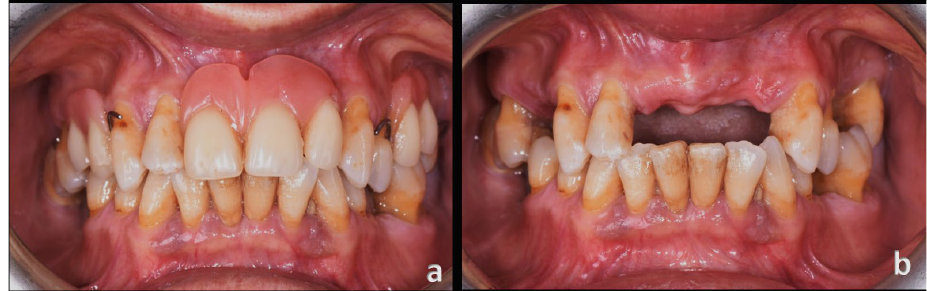
Figure 2. Intraoral view with ( a ) and without ( b ) upper removable partial denture. The patient’s intraoral records with and without the upper removable partial denture were taken with an intraoral scanner (Trios 3, 3Shape, Copenhagen, Denmark). The upper removable denture was also digitized. The occlusion was unstable with the remaining teeth, so the vertical dimension was recorded with the partial upper removable denture.